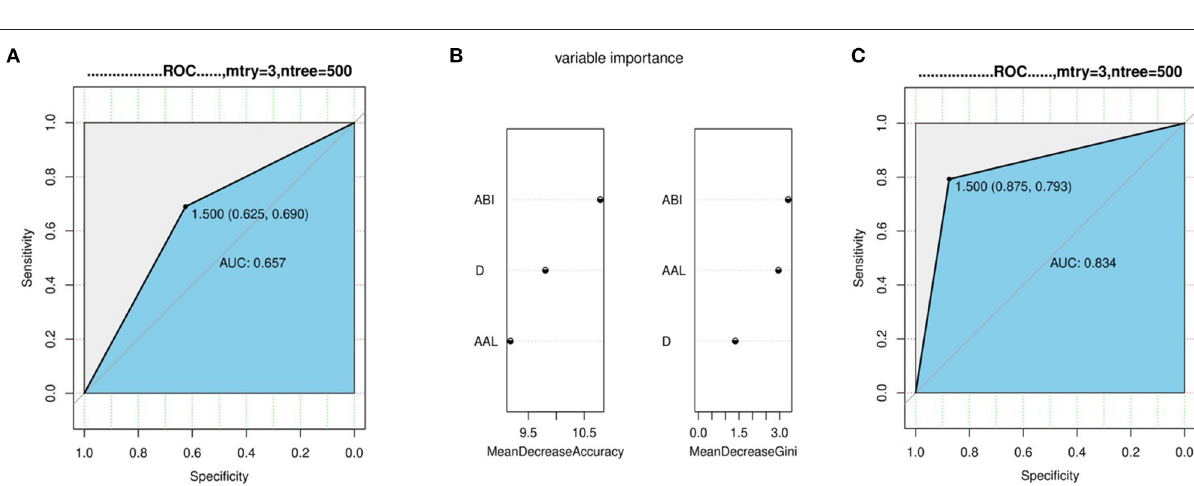
FIGURE 4 | Regression analysis with aneurysms and dissections. (A) The ability of diameter distinguish between dissection and aneurysm. (B,C) The variable importance and ability of diameter + AAL + ABI distinguish between dissection and